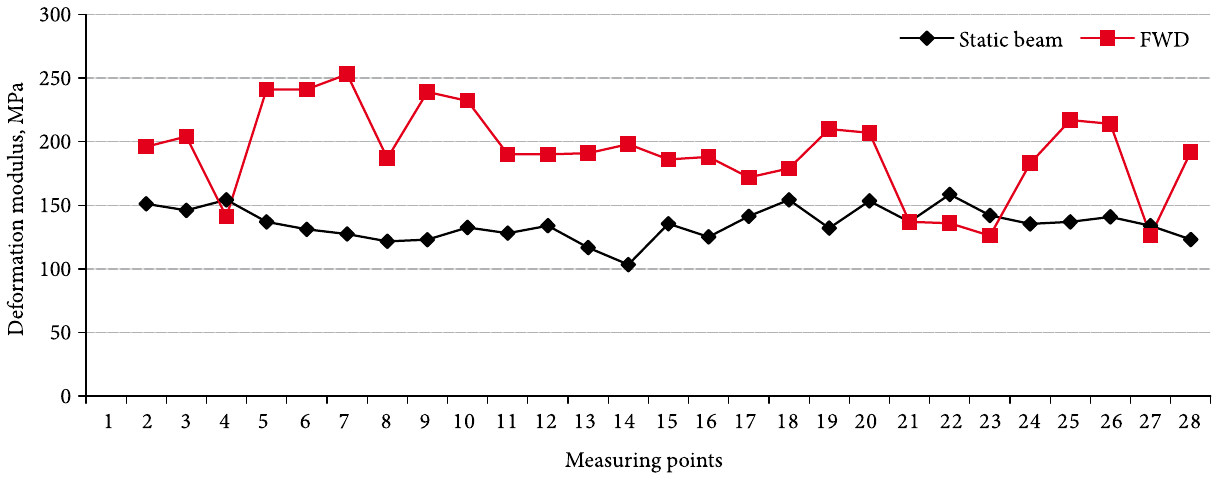
fig. 9. Measuring results of frost blanket course (right side)